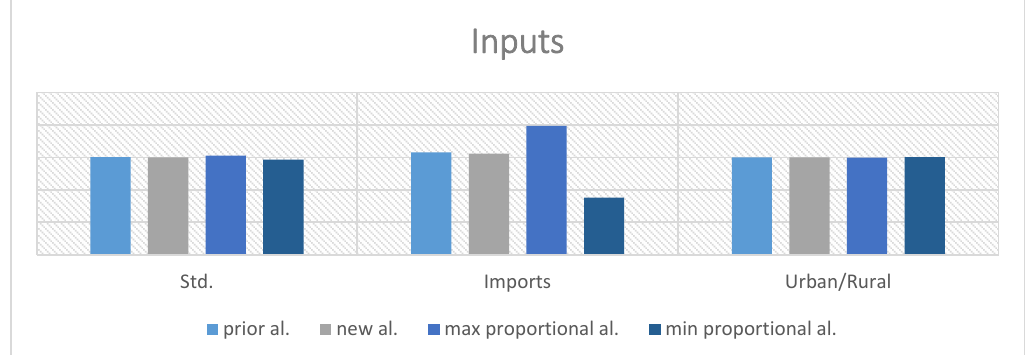
Fig. 2. The normalized amount of input indicators for the whole society